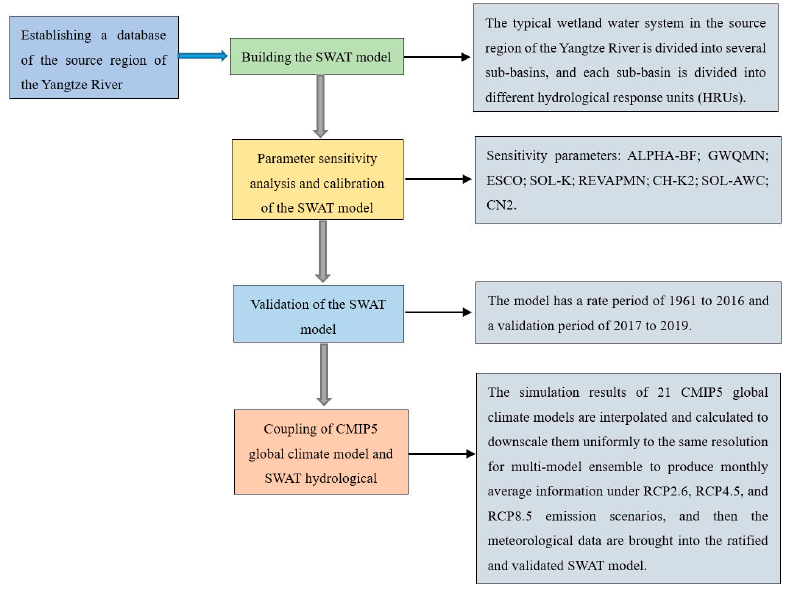
Figure 2. Water quality prediction method fl ow